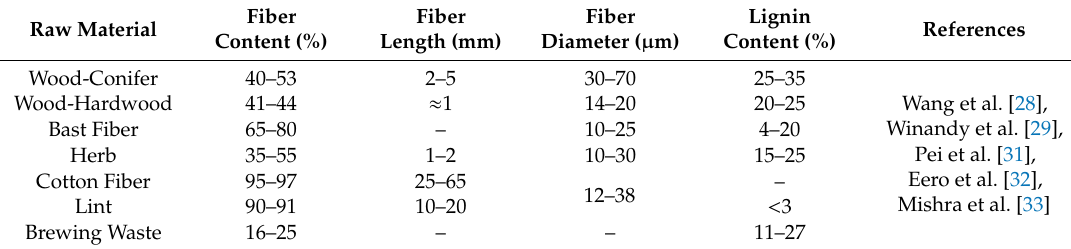
Table 1. Cellulose content and fiber length of common raw materials.